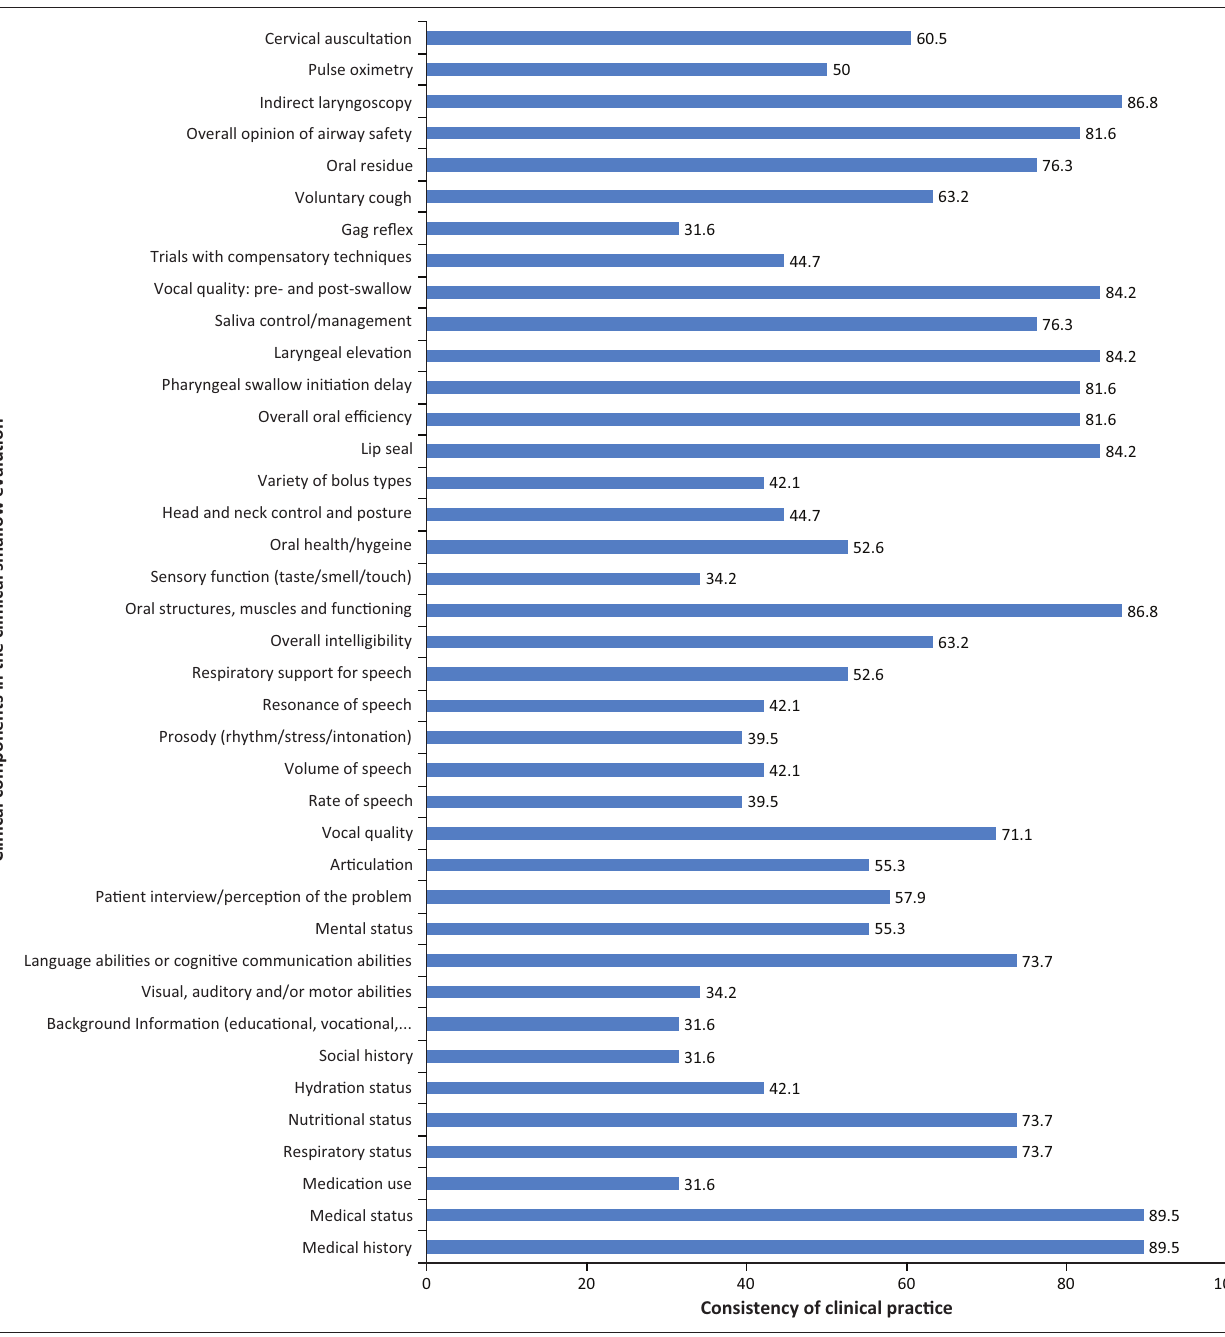
FIGURE 3: Consistency of clinical component